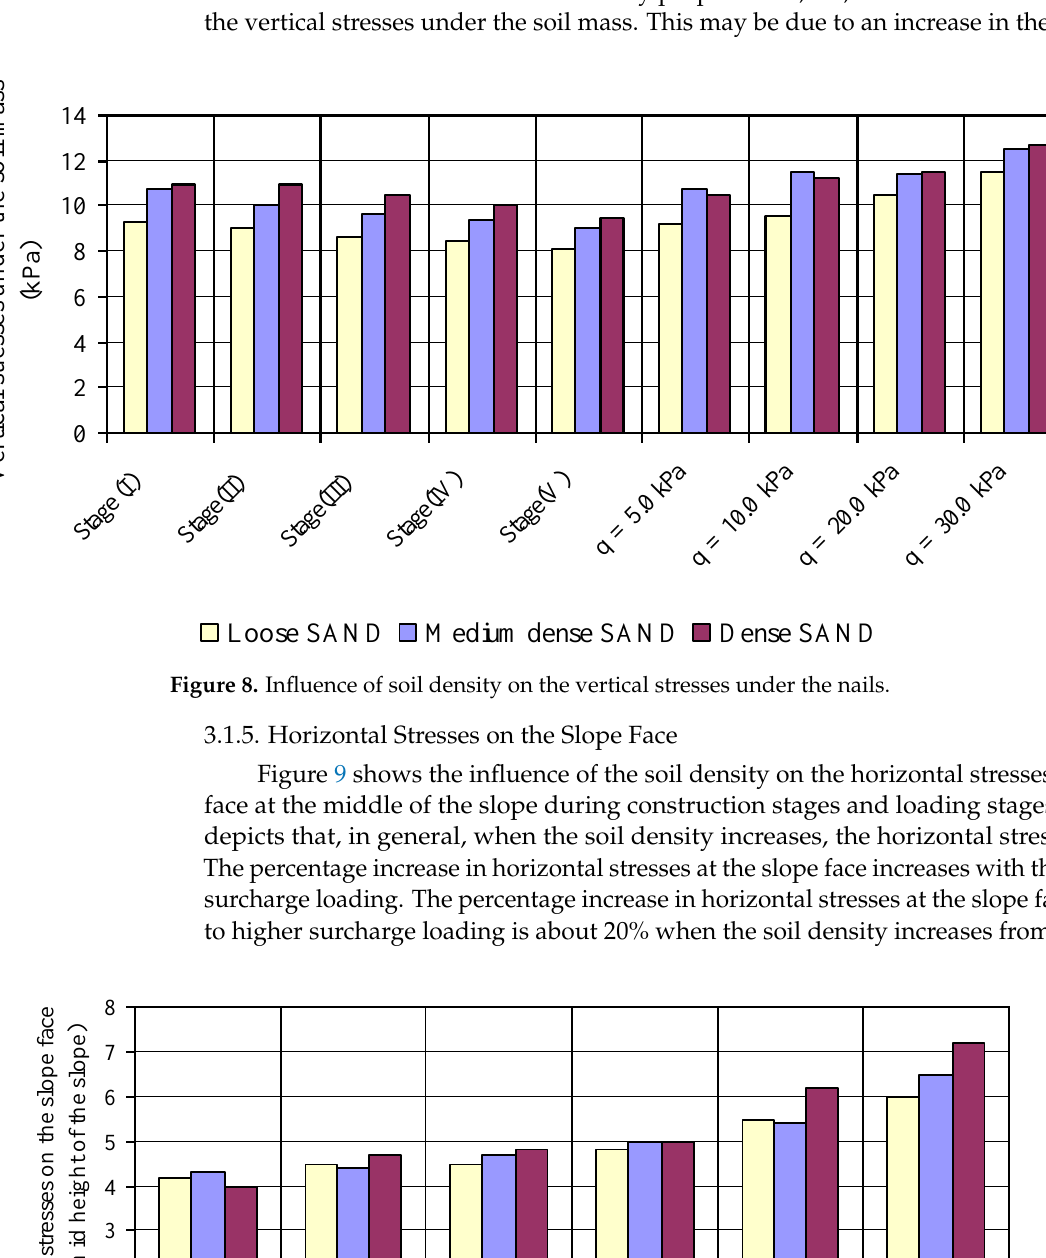
Figure 7. Influence of soil density on the maximum tensile force in the nails; ( a ) upper nail; ( b ) middle nail; ( c ) lower nail.